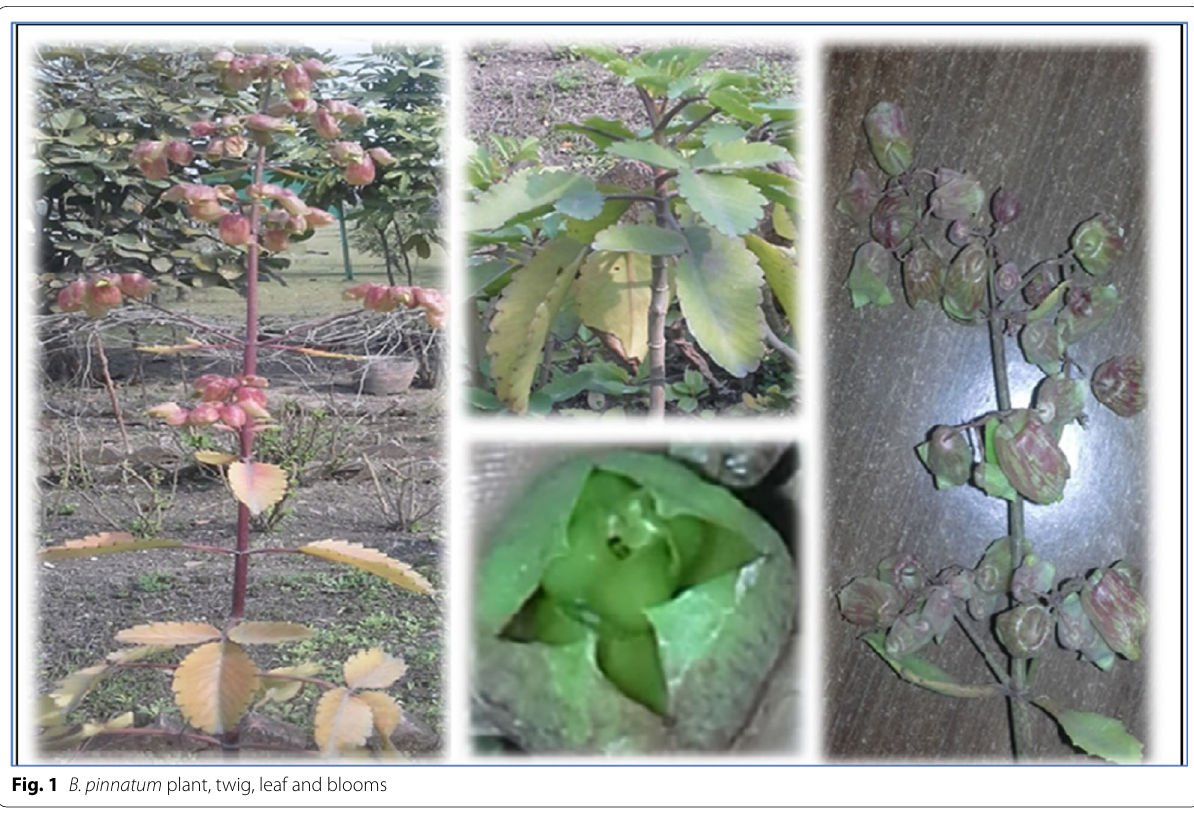
Fig. 1 B. pinnatum plant, twig, leaf and blooms